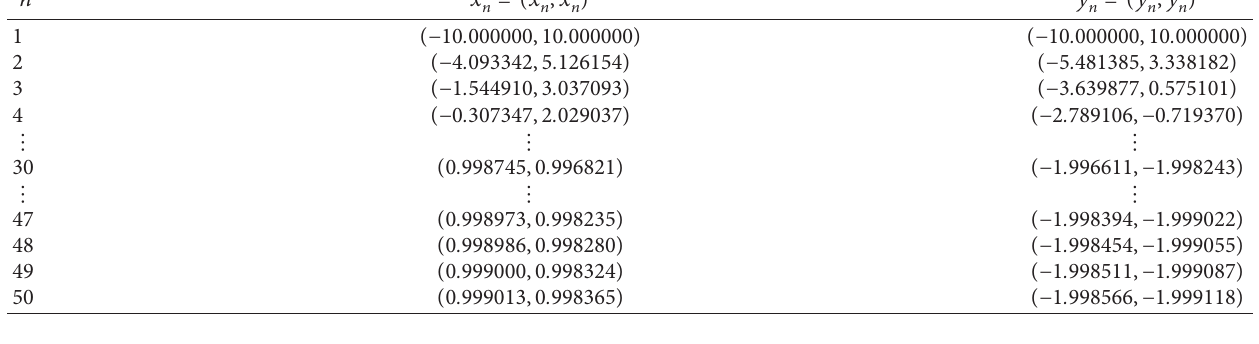
􏼈 􏼉 and y 􏼈 􏼉 with initial values x n n